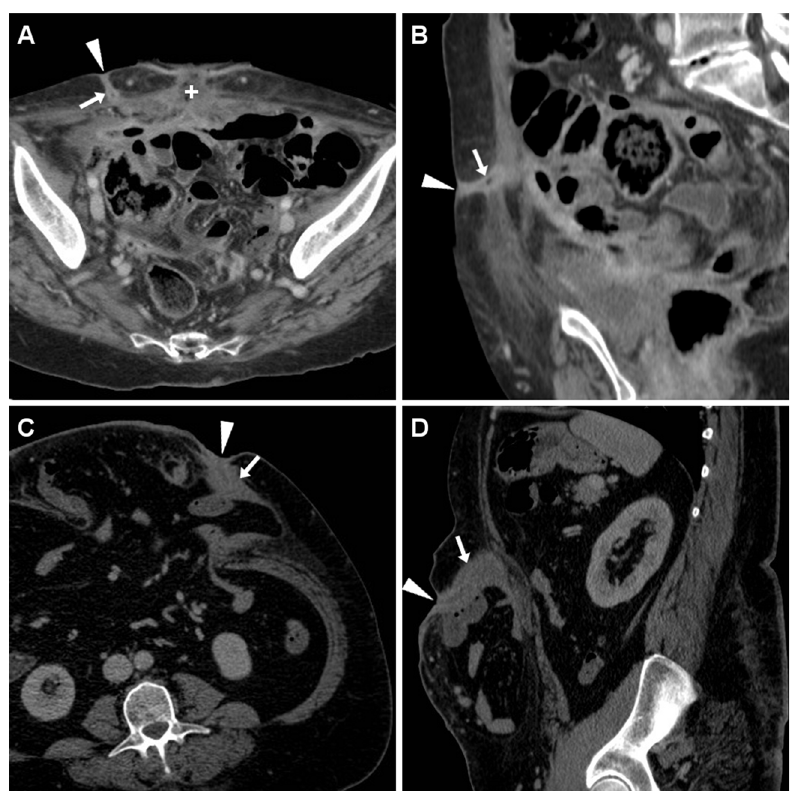
Fig. 4 Postoperative ECF with subcutaneous abscess formation in a 71-year-old woman, following resection of sigmoid colon diverticulitis, complicated by anastomotic dehiscence which required re-laparotomy, ileal resection, and temporary ileostomy. CT diagnosed communication